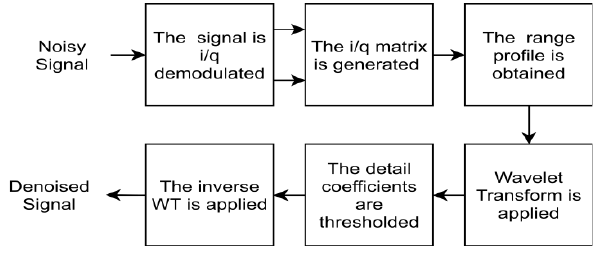
Figure 5: Denoising process of a SFCW radar signal In order to investigate the power of wavelet transform on different noise levels, the denoising process is done with the SNR of 5, 15 and 25 dB. The Gauss distributed noisy range profiles and their denoised forms are given in Figure 6.